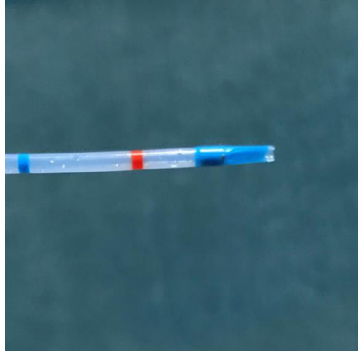
Figure 5. A hand-made “hitch-and-ride” catheter with a slit at its distal end.